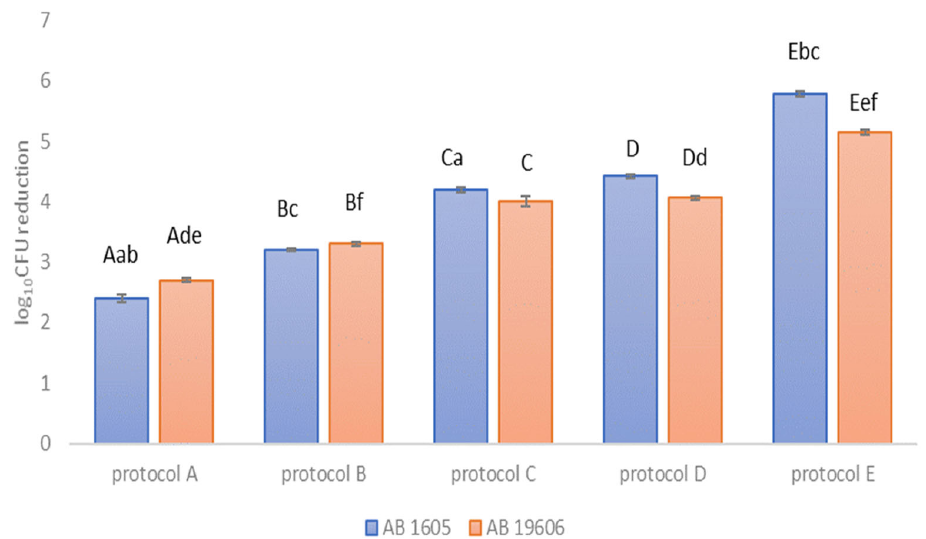
Figure 2. Viable bacteria count expressed as log 10 CFU reduction of Acinetobacter baumannii ATCC BAA-1605 and Acinetobacter baumannii ATCC 19606 formed on polystyrene with standard deviation. Protocol A marks disinfection with gaseous ozone, Protocol B disinfection with citric acid, Protocol C a combination of citric acid–gaseous ozone, Protocol D a combination of gaseous ozone–citric acid, and Protocol E a combination of citric acid–gaseous ozone–citric acid. Lowercase letters (a–f) express statistically significant differences between disinfection protocol and bacterial strain (Kruskal–Wallis U, p < 0.05). Capital letters (A, B, C, D, and E) mark statistically significant differences between different used bacterial strain per disinfection protocol.